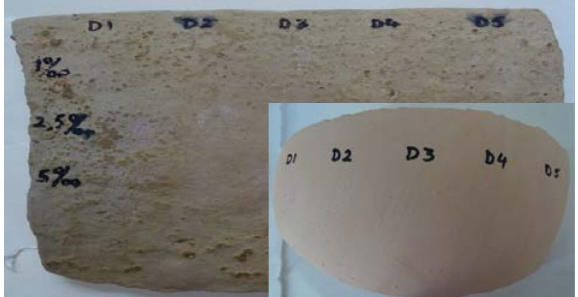
Figure 6. Recipes testing on real (back image) and simulated ceramic artefacts (front image)